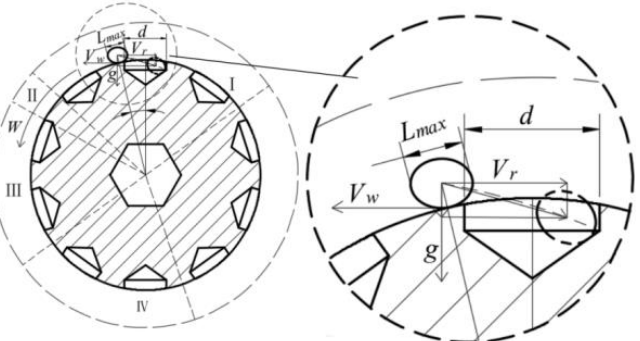
Figure 5. Kinematic analysis diagram of seed filling into the shaped hole. Note: v r is the ultimate relative velocity of the seed successfully entering the shape hole, m/s; L max is the maximum length of the seed, mm; g is the acceleration of gravity, m/s.